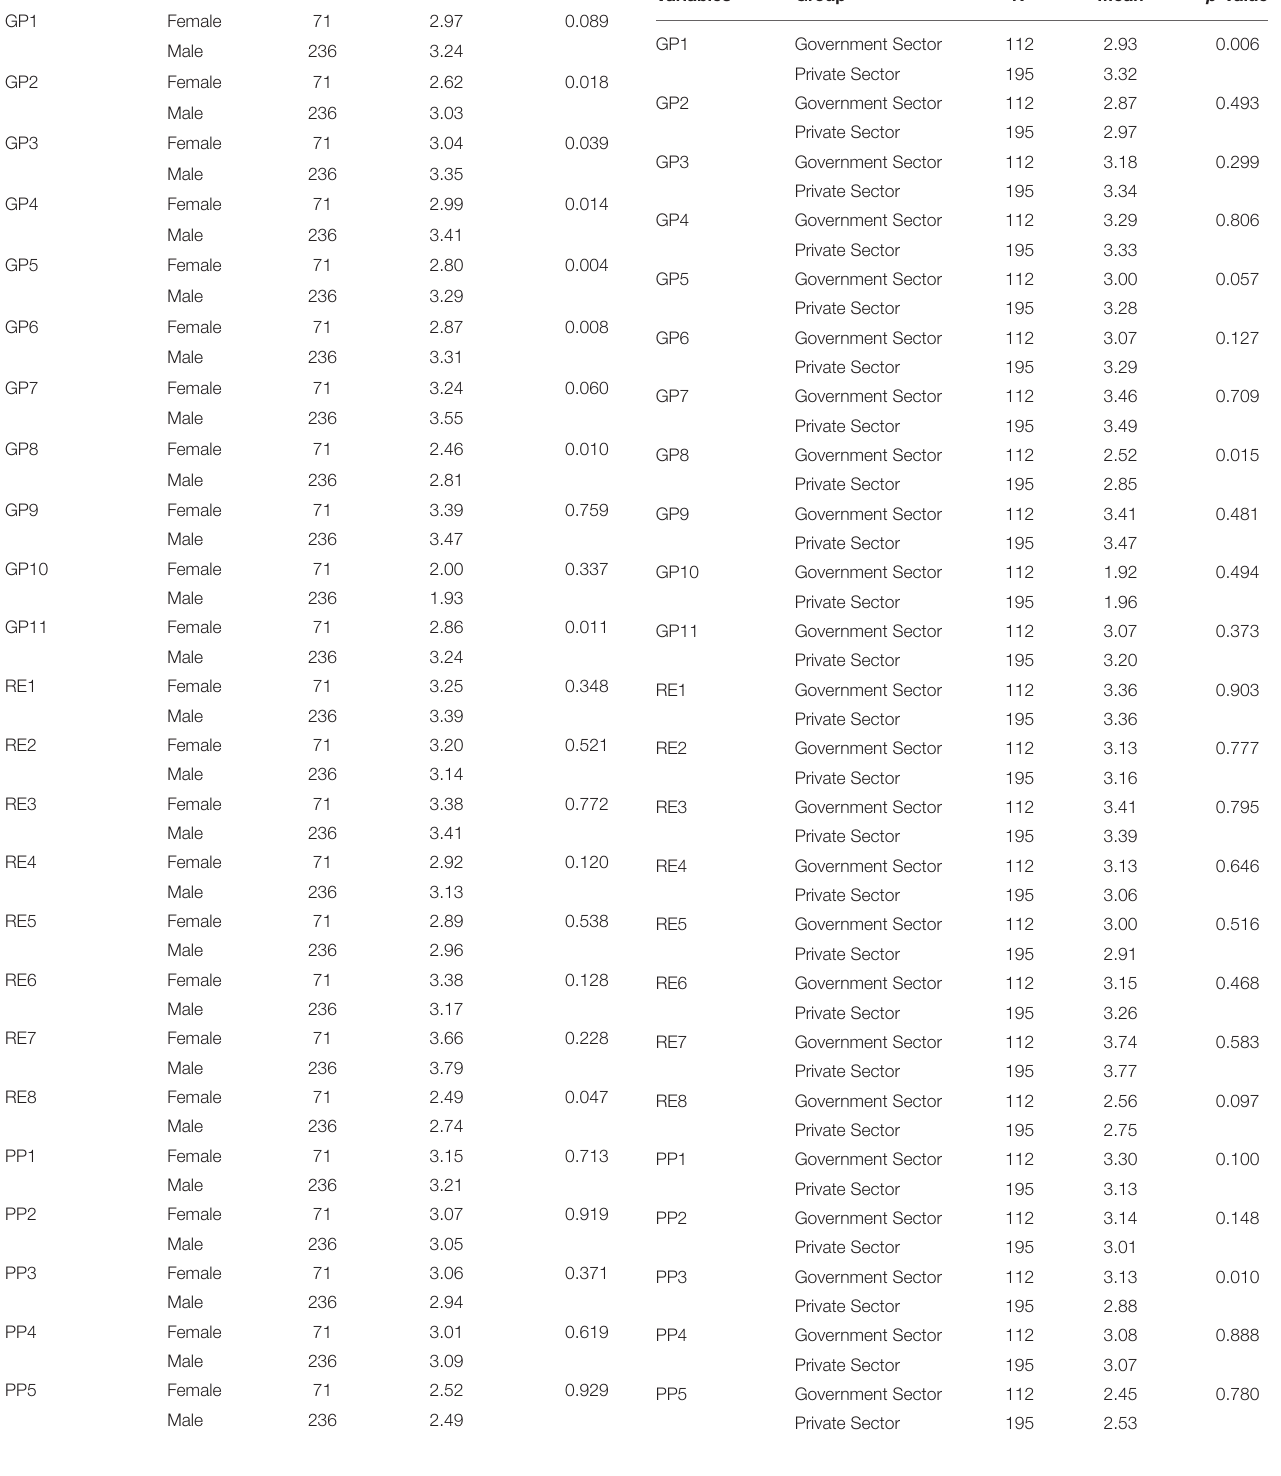
TABLE 7 | Test results of Mann-Whitney U test on female and male groups. Variables